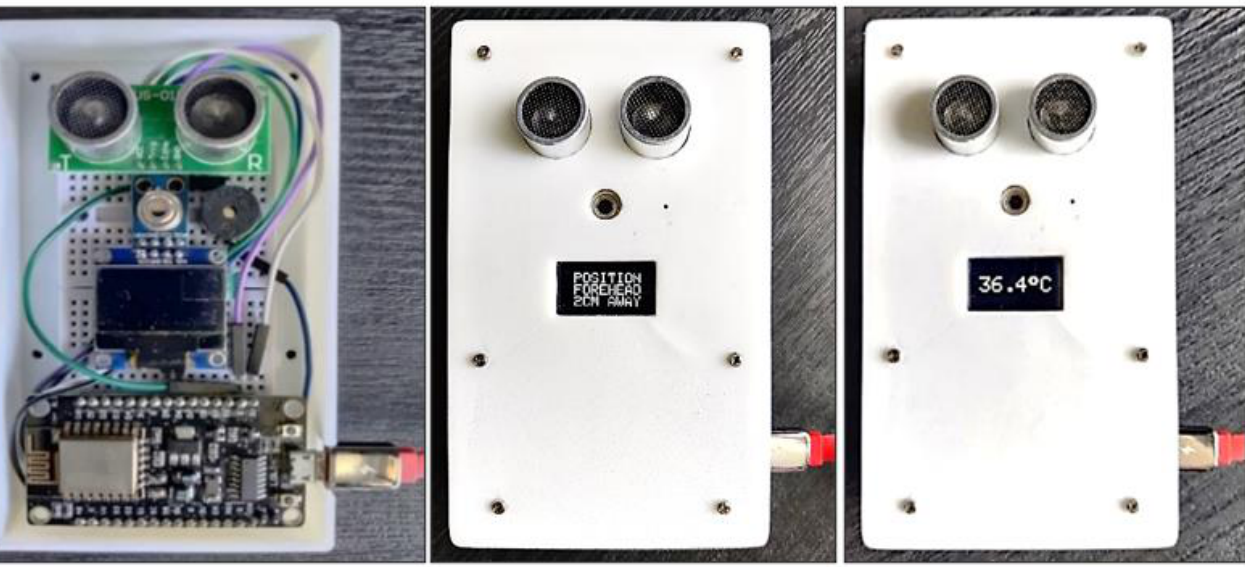
Figure 5. Enclosure CAD model for the body temperature screening system.